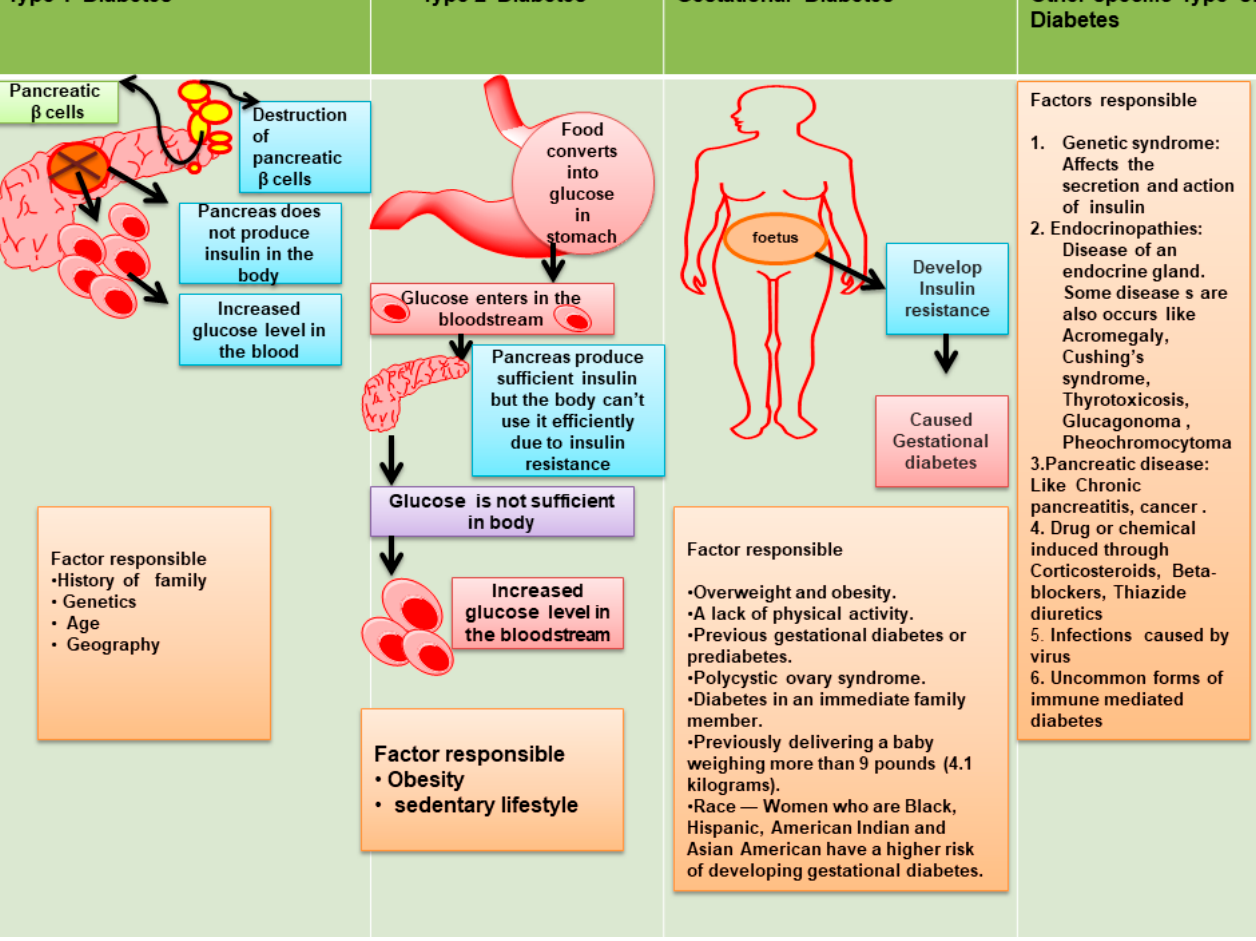
Figure 1. Types of Diabetes mellitus (new classification